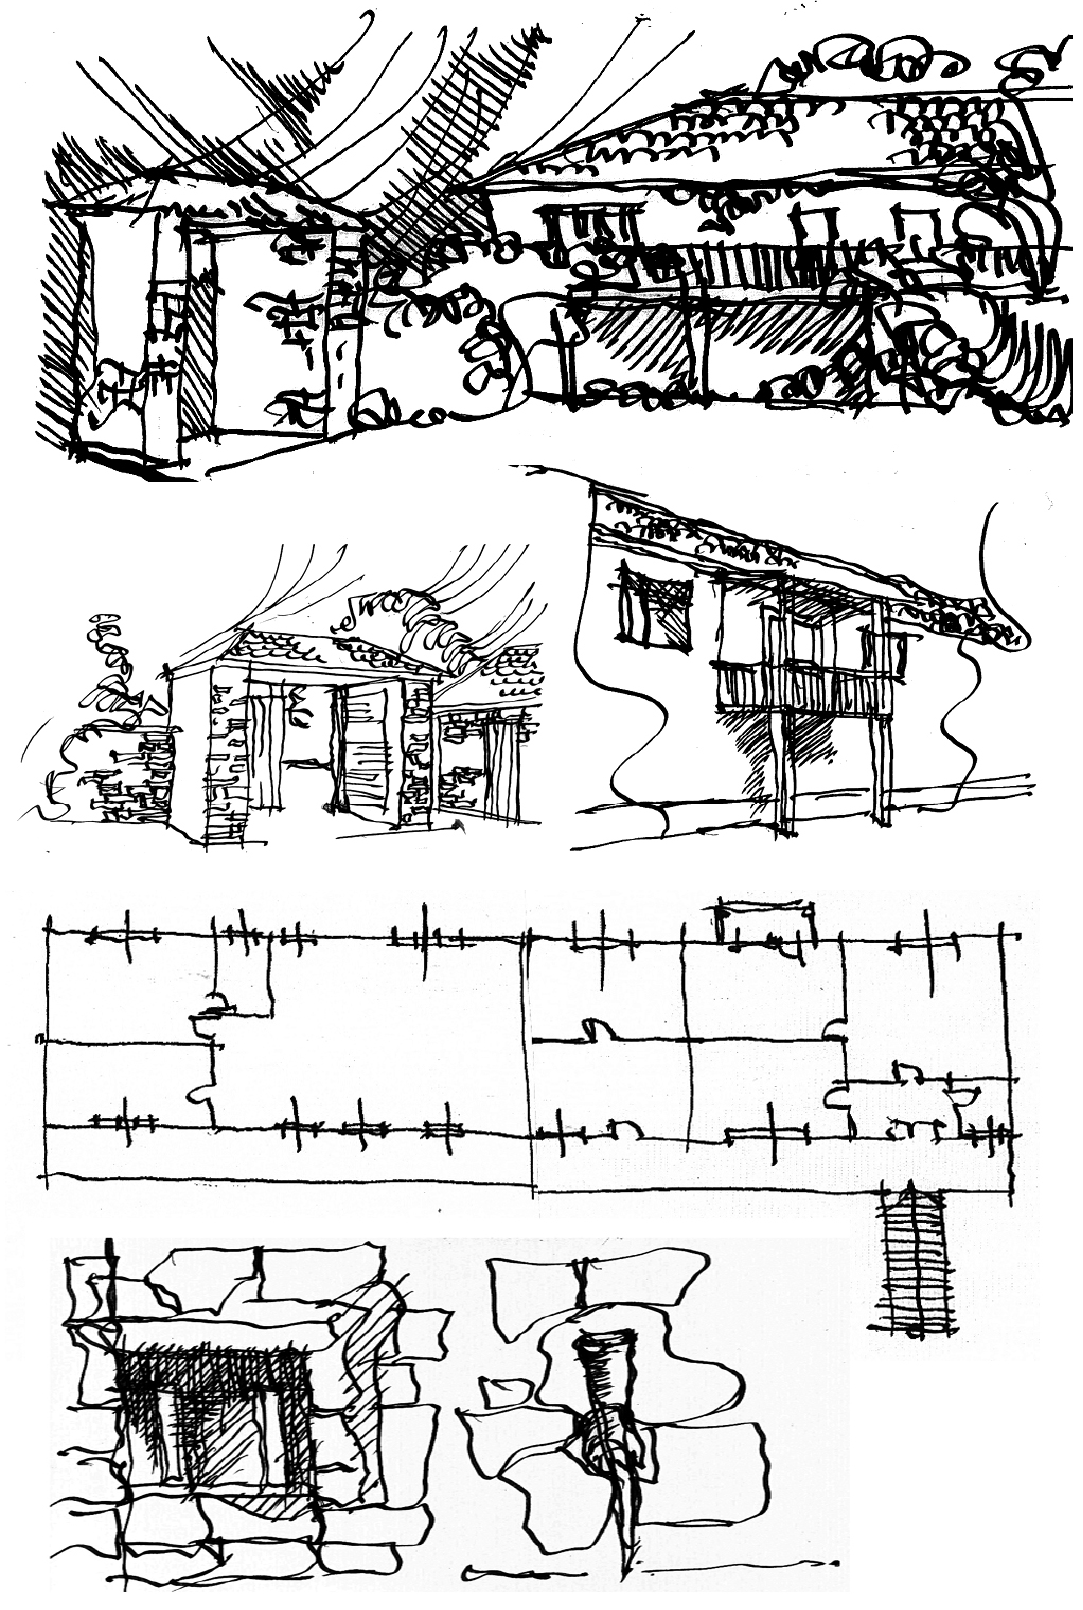
Figure 17. Drawing of the House of Maric, Zeta region, Montenegro (S. G. Popovic).